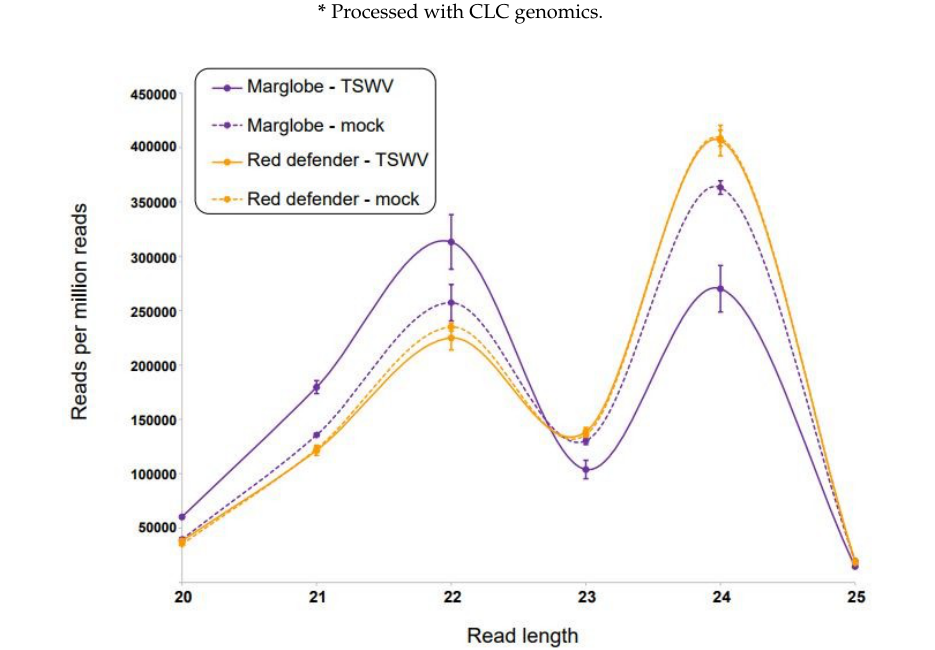
Figure 2. Distribution of the read counts for small RNAs between 20 to 25 nt in length. Each peak corresponds to the average of three biological replicates with standard error bars. Continuous lines are tomato spotted wilt virus (TSWV)-infected treatment, while broken lines are mock control. Purple corresponds to tomato cv. Marglobe, the susceptible genotype Sw -5( − ), while the yellow line corresponds to cv. Red Defender, the resistant genotype, Sw -5( +